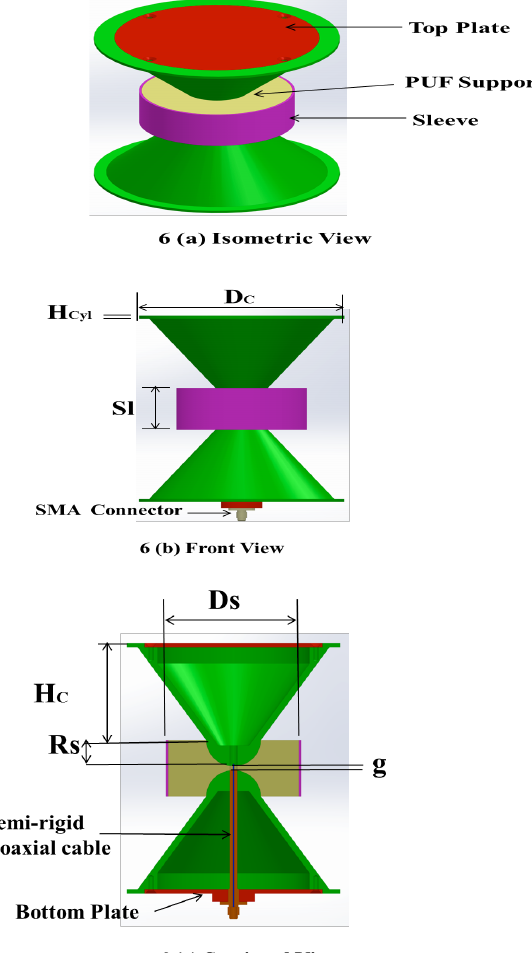
fig. 6 showing its isometric, front and sectional views.